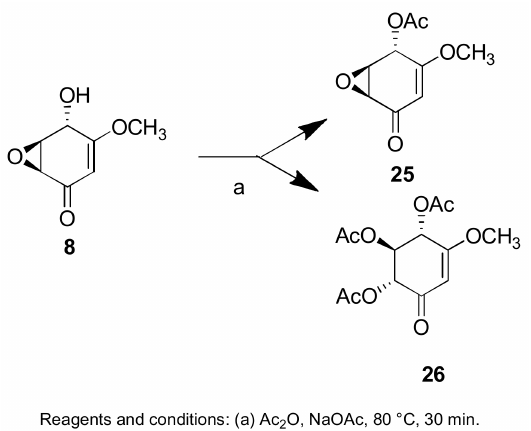
Scheme 5. The structures of epi -sphaeropsidone ( 8 ) and its derivatives ( 25 and 26